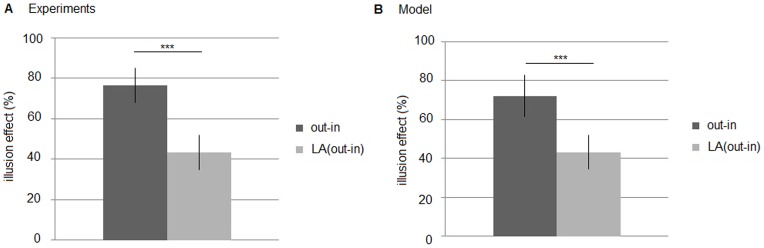
Mean effect percentage of the Müller-Lyer illusion.(a). Experimental results. (b). Model results. “Out-in” indicates the wings-out and wings-in configurations; “LA (out-in)” indicates the large angled configurations (***P<0.005). Lateral lines indicate error bars.